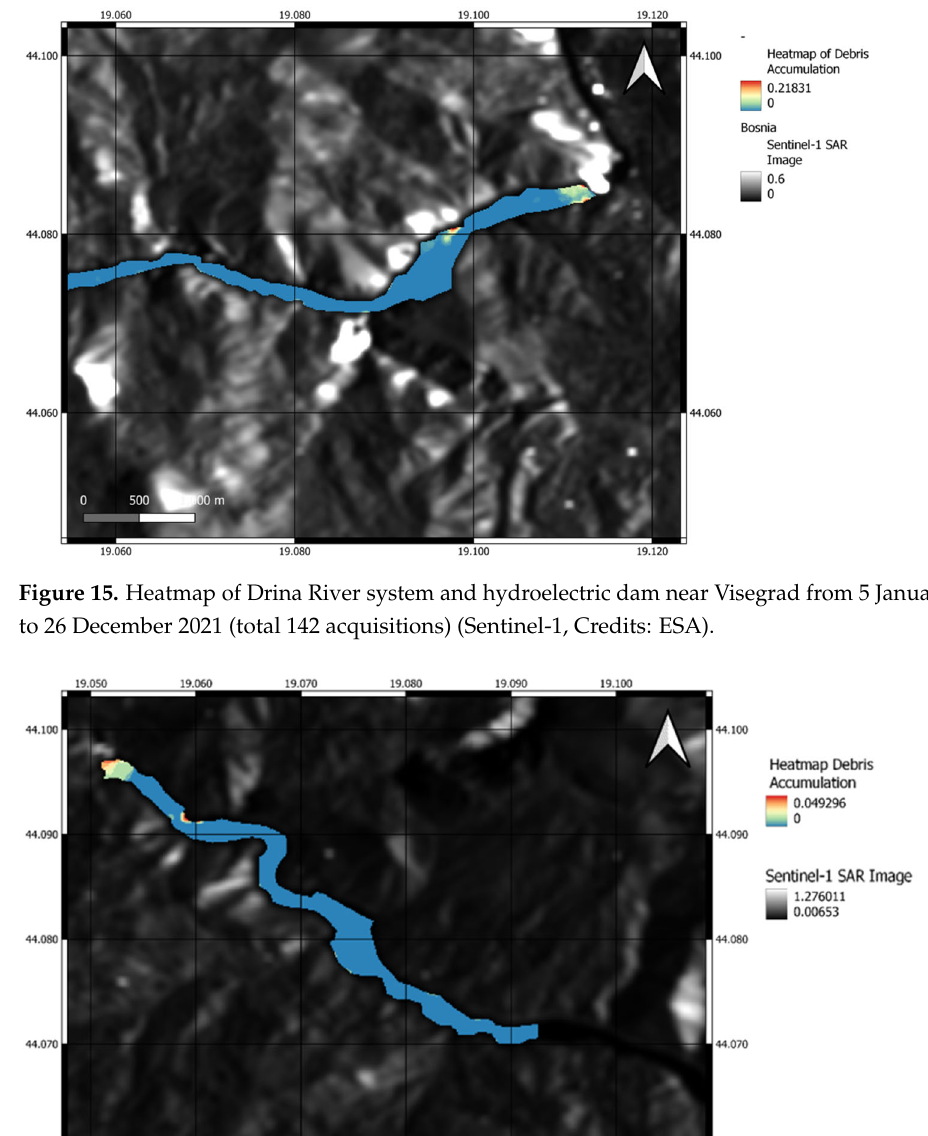
Figure 16. Heatmap of Potpecko Lake system and hydroelectric dam from 5 January 2019 to 26 December 2021 (total 142 acquisitions). Basemap: multitemporal average of Sentinel-1 VV images. Colour: heatmap (Sentinel-1, Credits: